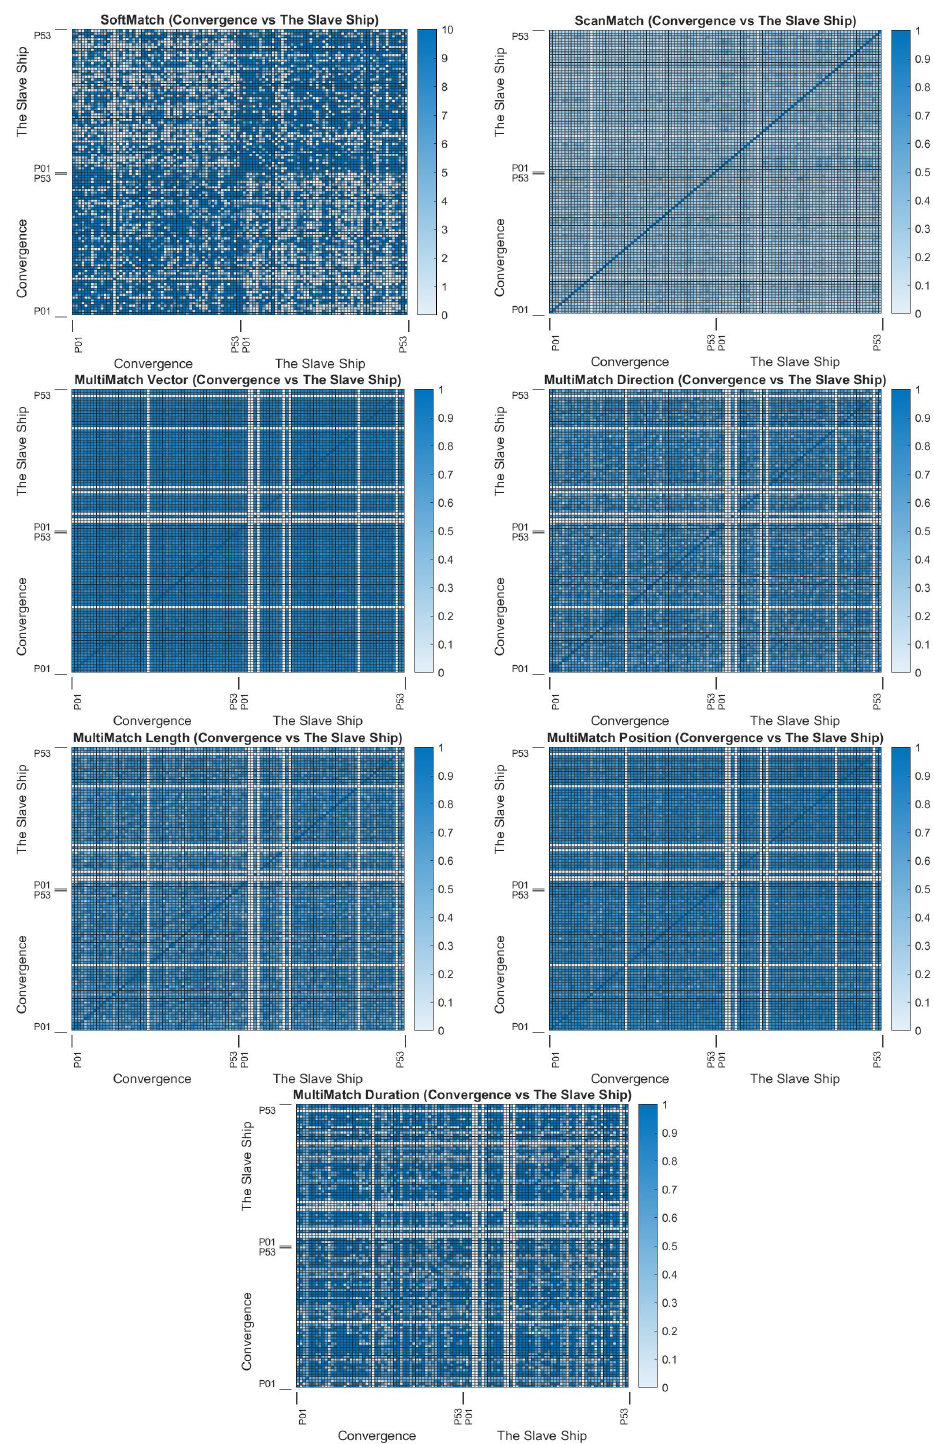
Figure A12. SoftMatch, ScanMatch, and MultiMatch heatmaps for empirical evaluation. Stimuli matched are Jackson Pollock’s Convergence (1952) and William Turner’s The Slave Ship